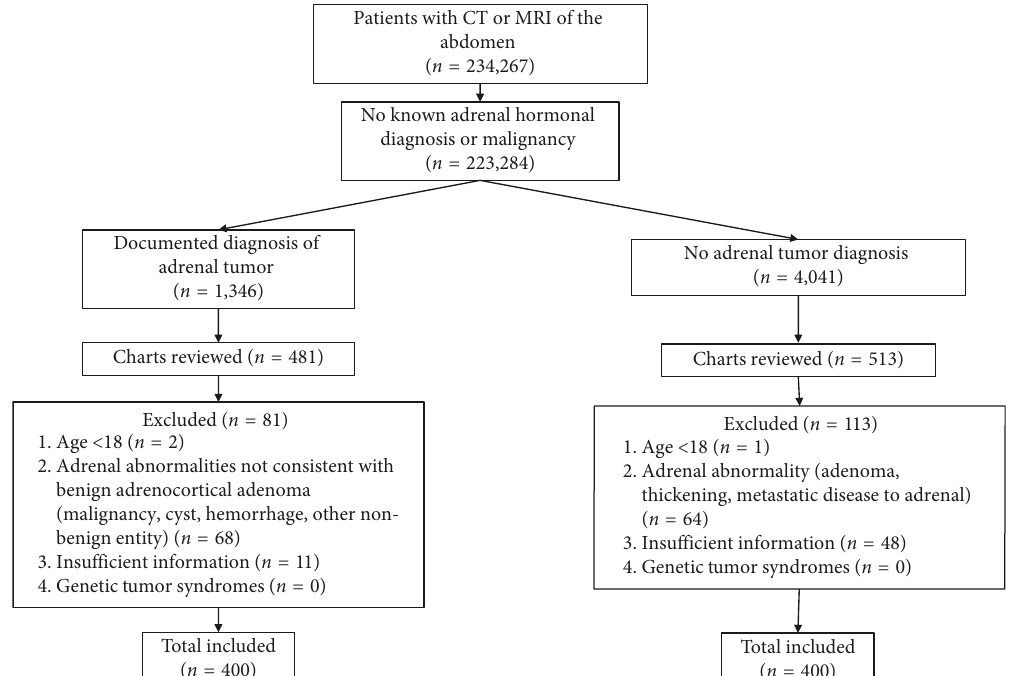
Figure 1: Study participant inclusion process. Participants were selected from patients who underwent abdominal CT or MRI at our